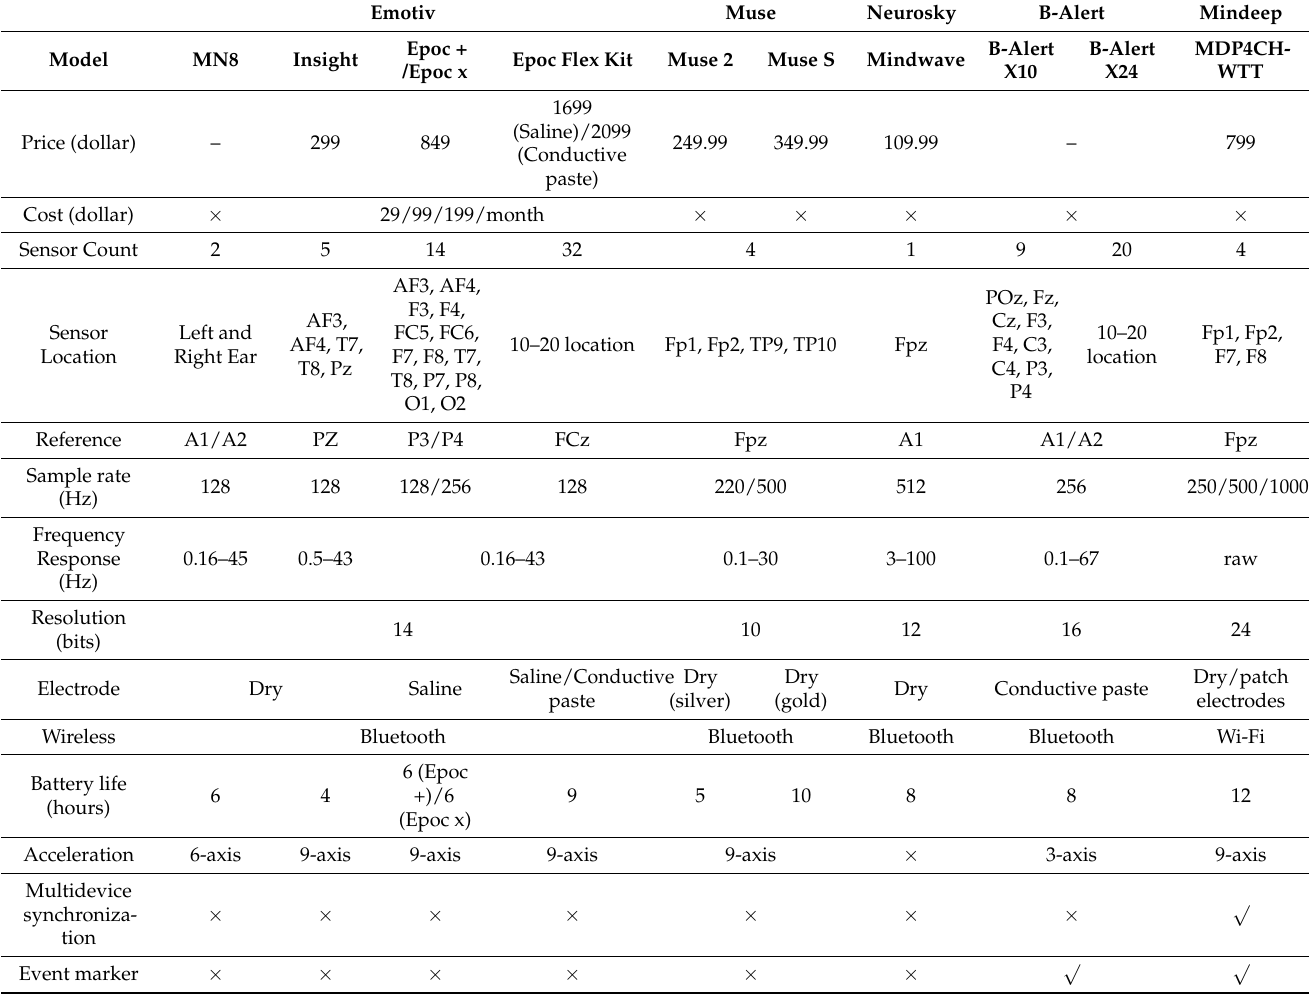
Table 4. Comparison of portable EEG